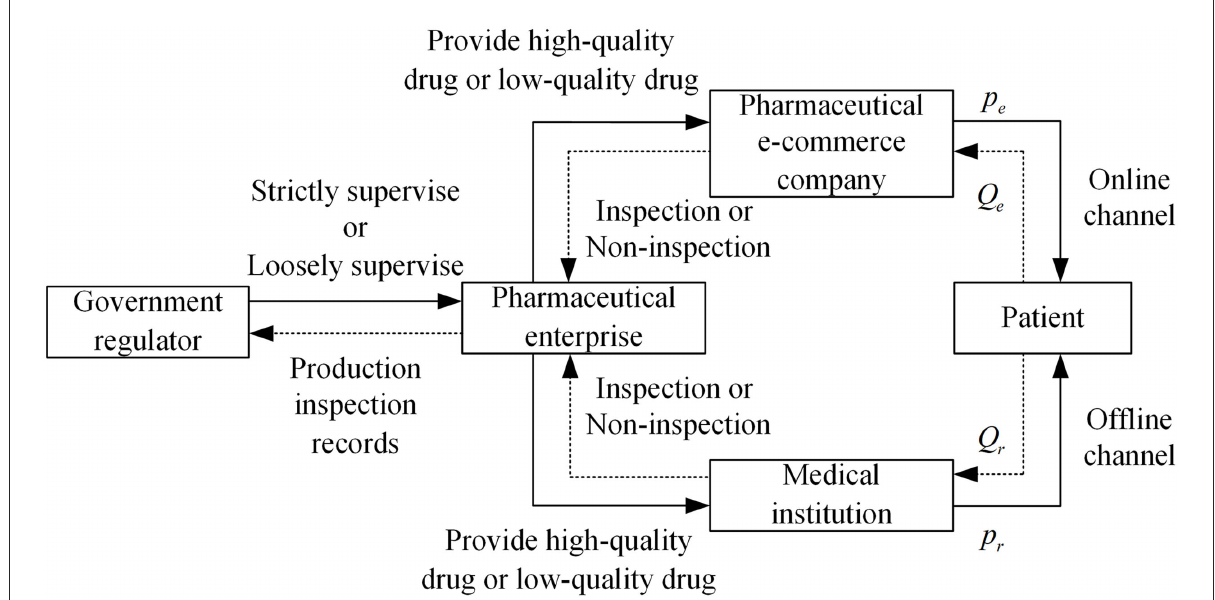
FIGURE1 Drugs quality regulatory structure relationship. Figure is the structural relationship diagram that shows the relationship among government regulator, pharmaceutical enterprises, medical institutions, and pharmaceutical e-commerce companies in the drugs quality supervision of different distribution channels in pharmaceutical supply chain.